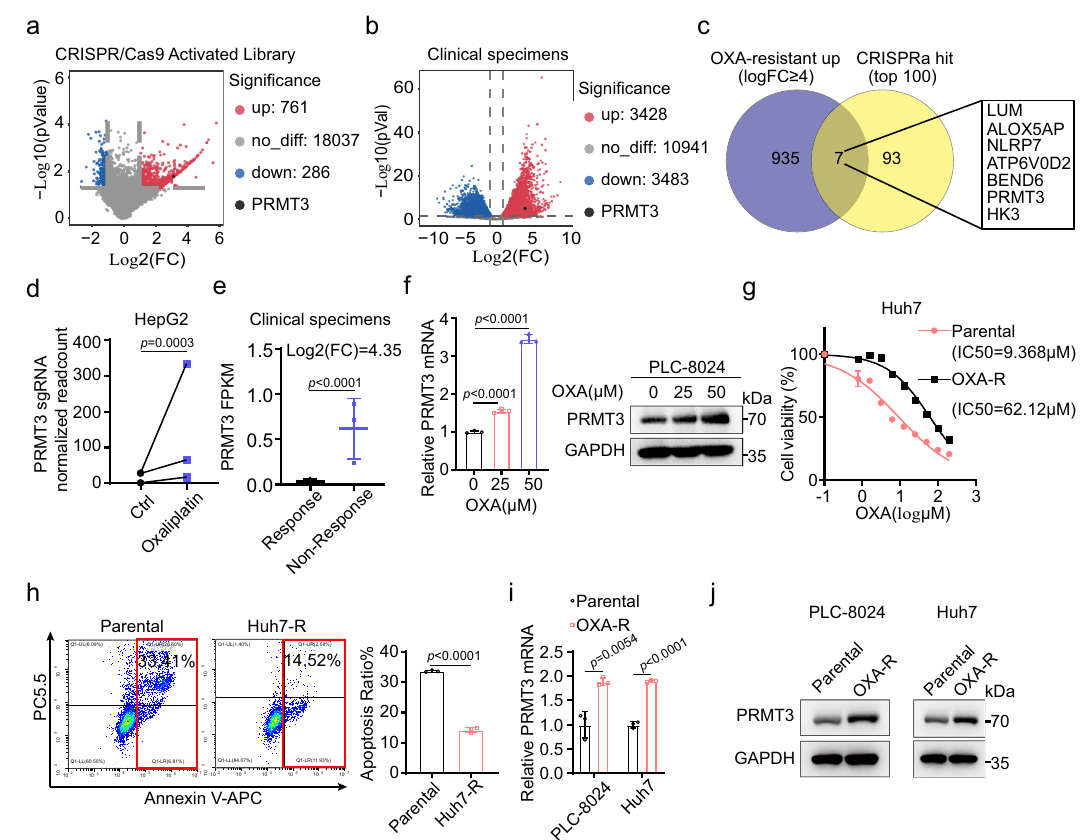
Fig.1|CRISPRactivationscreenandtranscriptomeanalysisofpatientsamples identifyPRMT3 asacandidatedriver forOXA resistancein HCC. a Volcano plot reveals differential gRNAs targeting genes of genome-wide CRISPRa screen during OXA treatment. b Volcano plot shows the differentially expressed genes identi fi ed from RNA-seq analysis of HCC patient samples treated with OXA-based HAIC (Responders VS Non-responders). c Venn diagram showing top candidate genes involved in OXA resistance based on CRISPRa screen and RNA-seq analysis of HCC patient samples. d PRMT3 sgRNAs were enriched in OXA-treated HepG2 cells compared to vehicle-treated HepG2 cells. e Comparison of PRMT3 mRNA expres- sion (FKPM) in tumors from patients treated with OXA who were de fi ned as responders and non-responders. f The mRNA and protein level of PRMT3 in PLC-